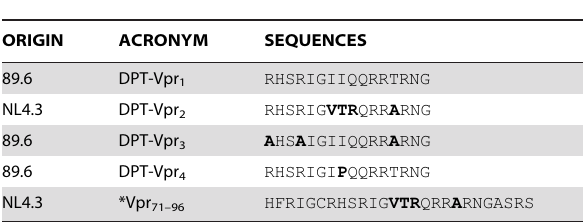
Table 2. Origin of peptides containing wild type and mutated Vpr sequences derived from 89.6 and